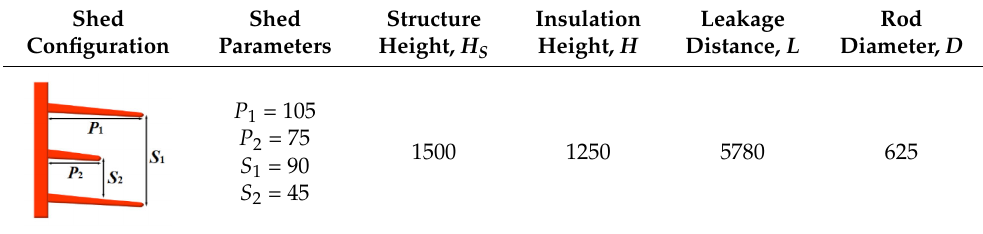
Table 1. Parameters of specimen